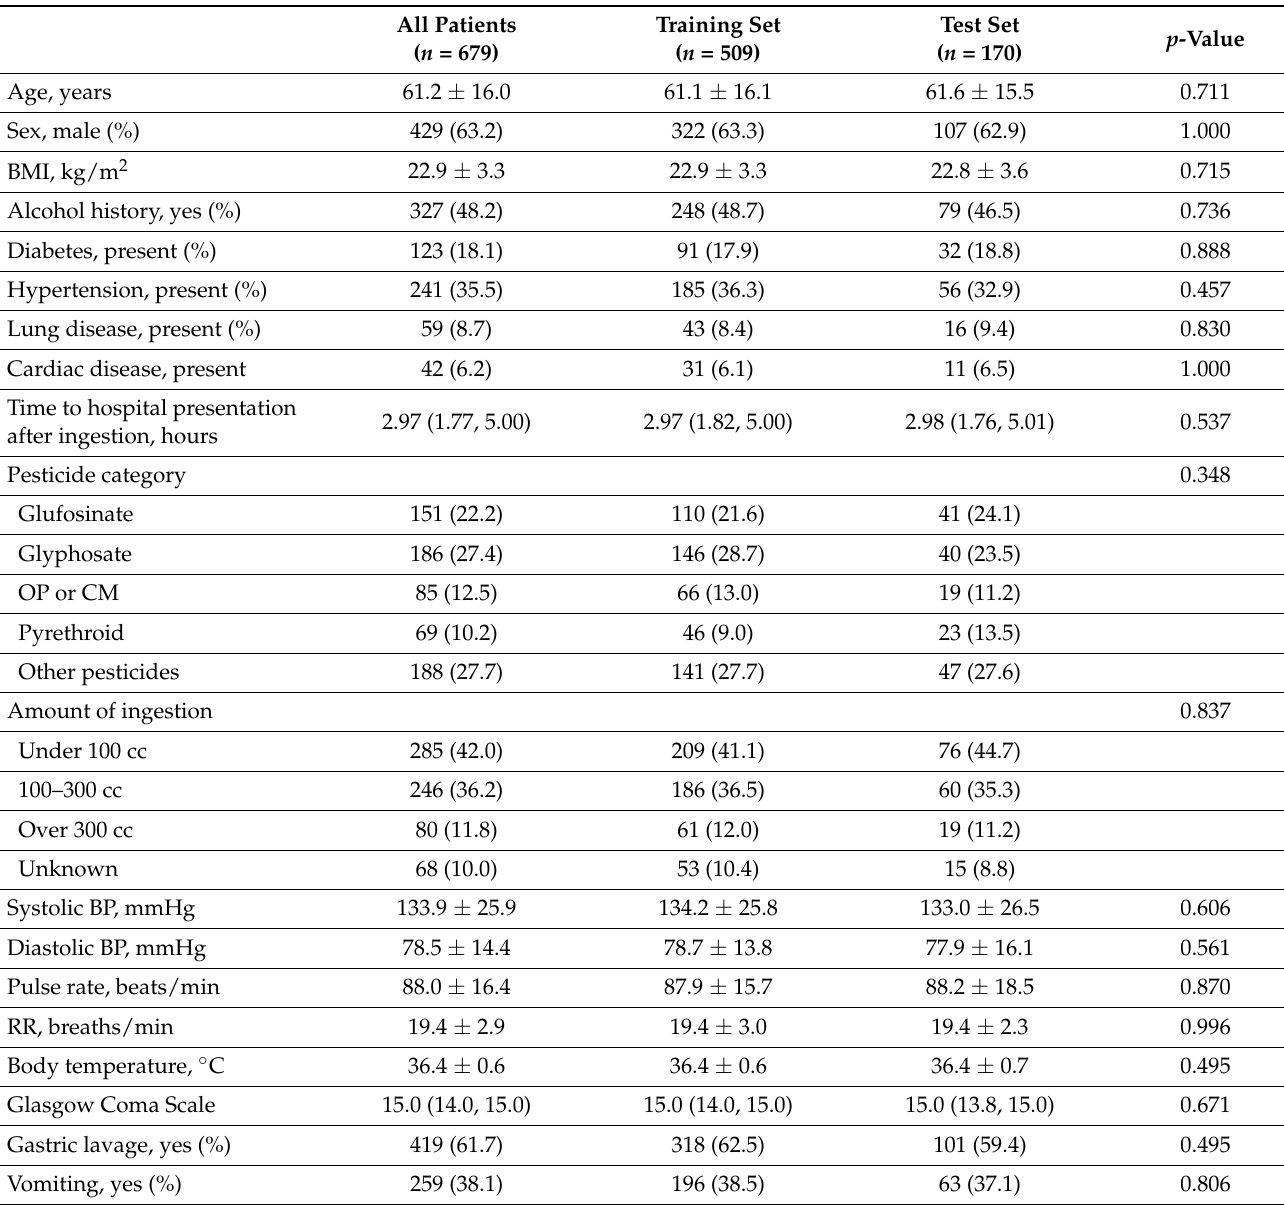
Table 1. Baseline characteristics of study